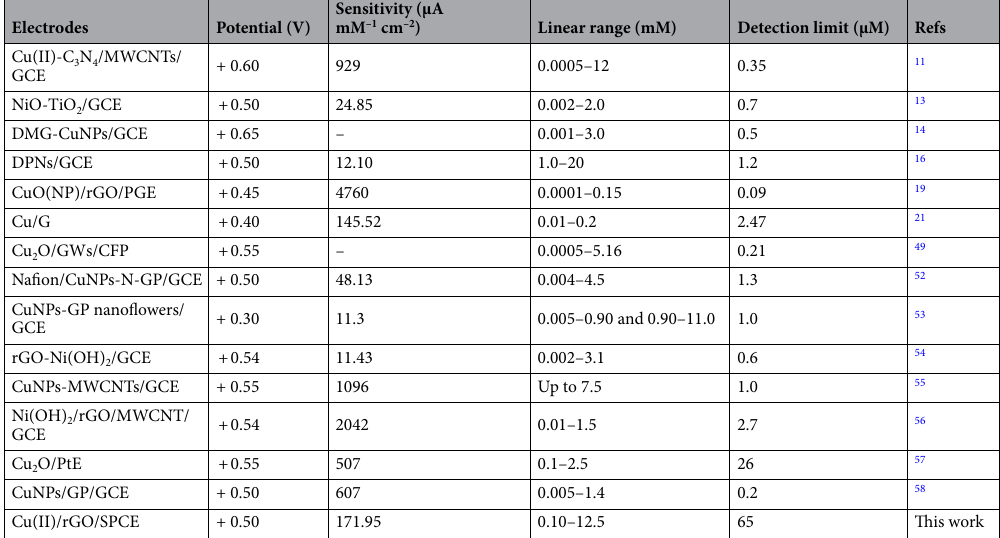
Table 1. Comparison of electrocatalytic performances of Cu-based electrodes for electrochemical non- enzymatic glucose sensors. CuNPs copper nanoparticles, Cu(II) copper(II) ion, GCE glassy carbon electrode, MWCNTs multi-walled carbon nanotubes, C 3 N 4 graphitic carbon nitride, CuNPs-N-GP copper nanoparticles decorated nitrogen-doped GP, DMG dimethylglycoxime, rGO reduced graphene oxide, SPCE screen-printed carbon electrode, DPNs three-dimensional dendritic Pt nanostructures, NiO nikle oxide, Ni(OH) 2 nikle hydroxide nanoparticles, TiO 2 nanostructured titanium dioxide, CuO(NP) copper oxide nanoparticles, PGE pencil graphite electrode, G glass substrate, Cu 2 O copper oxide nanoparticles, GWs three-dimensional graphene wall, CFP carbon fiber paper, PtE platinum